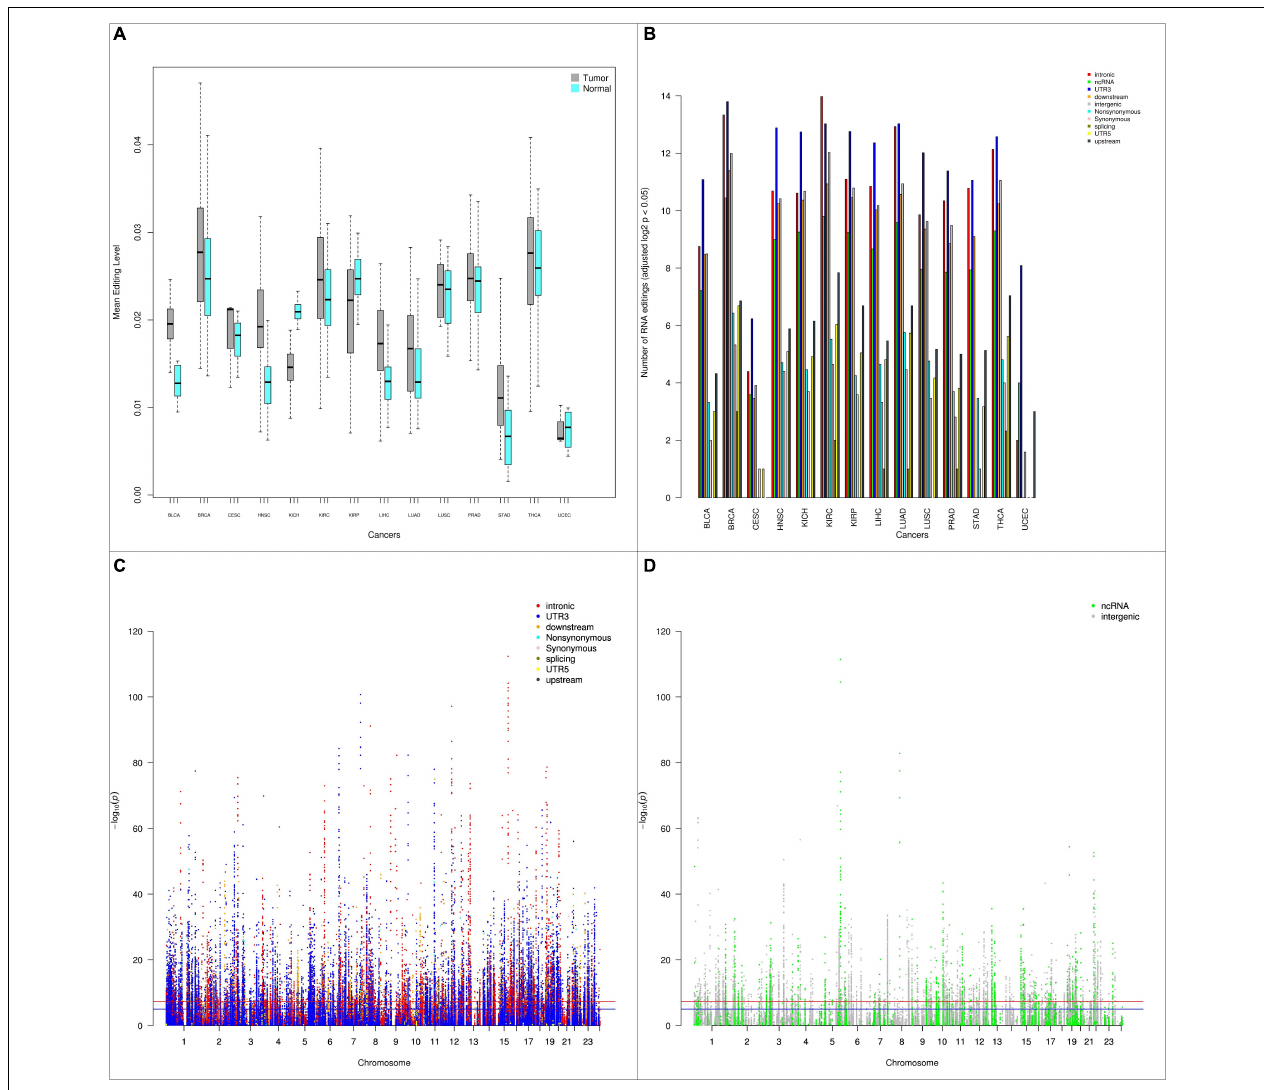
FIGURE 3 | (A) Box plots depicting the average RNA editing levels between paired tumor and normal samples by cancer type. Majority of the cancer types have higher RNA editing levels in tumor than normal. (B) Barplot depicting number of RNA editing events with p < 0.05 between tumor and normal by cancer type and by genomic location categories. (C) Manhattan plot of genome-wide differential RNA editing level results for protein-coding genes. (D) Manhattan plot of genome-wide differential RNA editing level results for lincRNA and